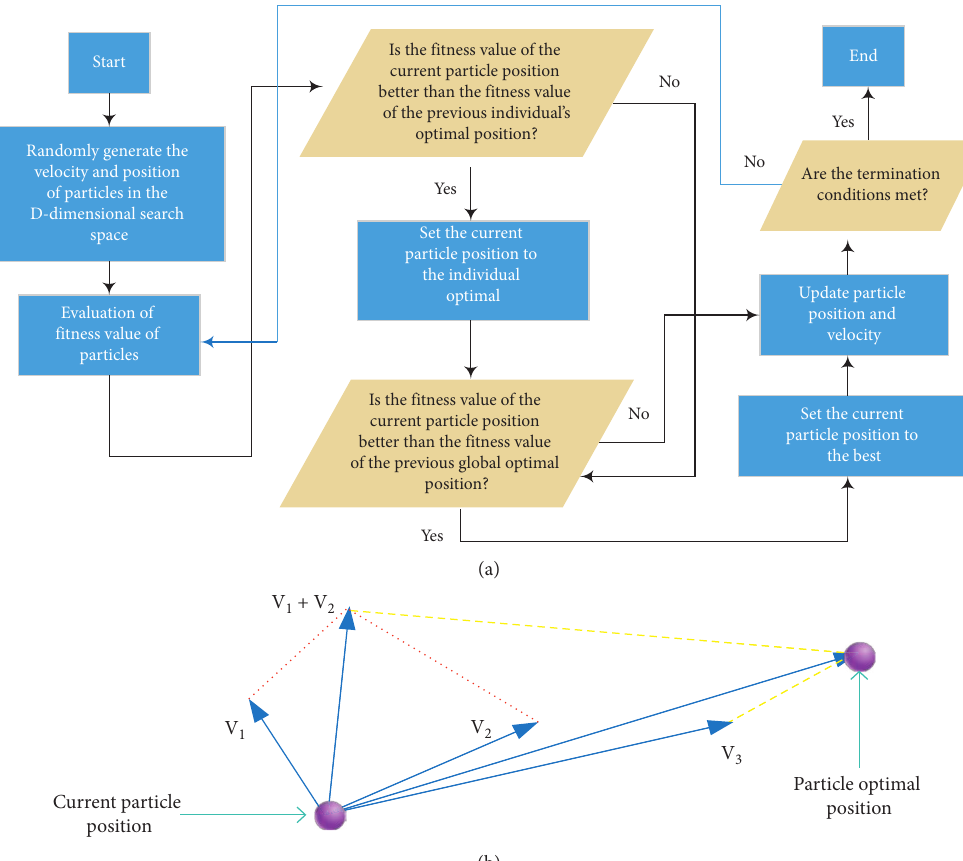
Figure 3: Particle swarm algorithm calculation steps and particle position update. (a) Particle swarm algorithm flow chart. (b) Schematic diagram of particle position